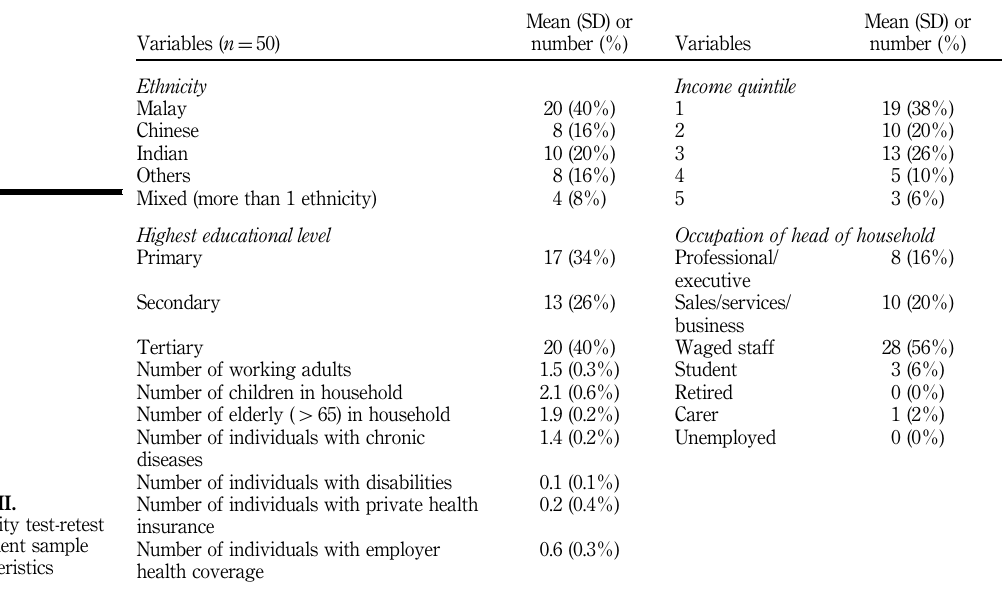
Table II. Reliability test-retest component sample